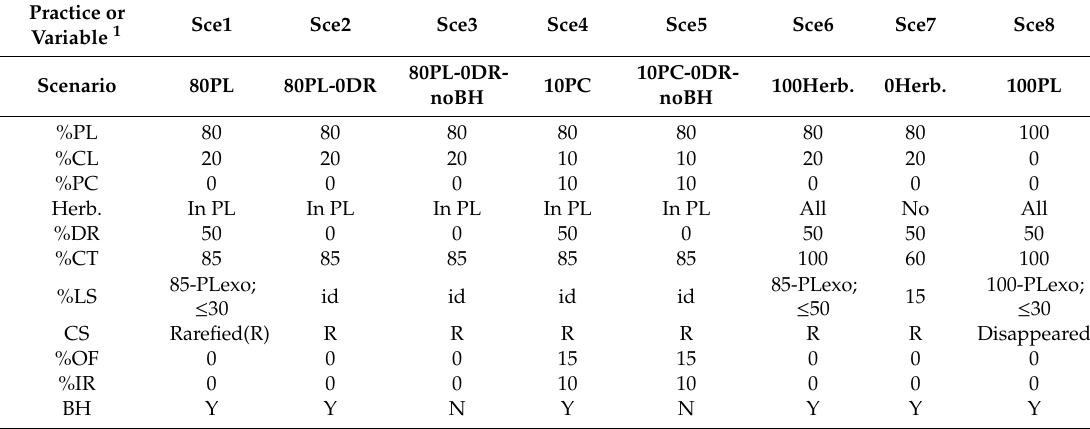
Table 7. Extreme scenarios’ descriptions.